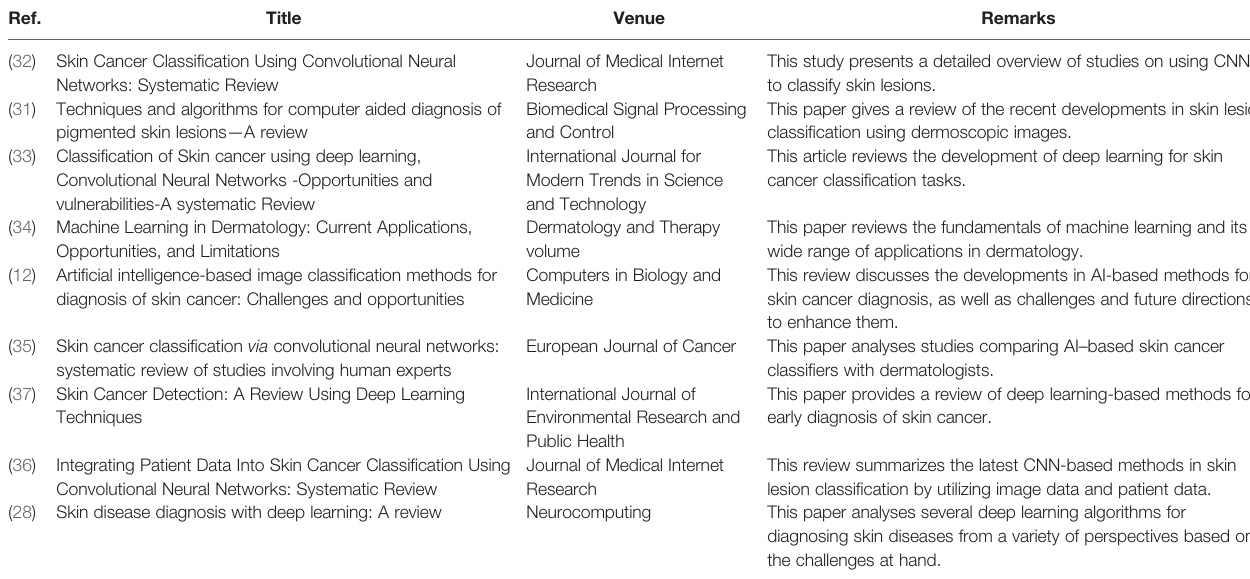
TABLE 1 | A summary of the current review related to skin cancer classi fi cation.